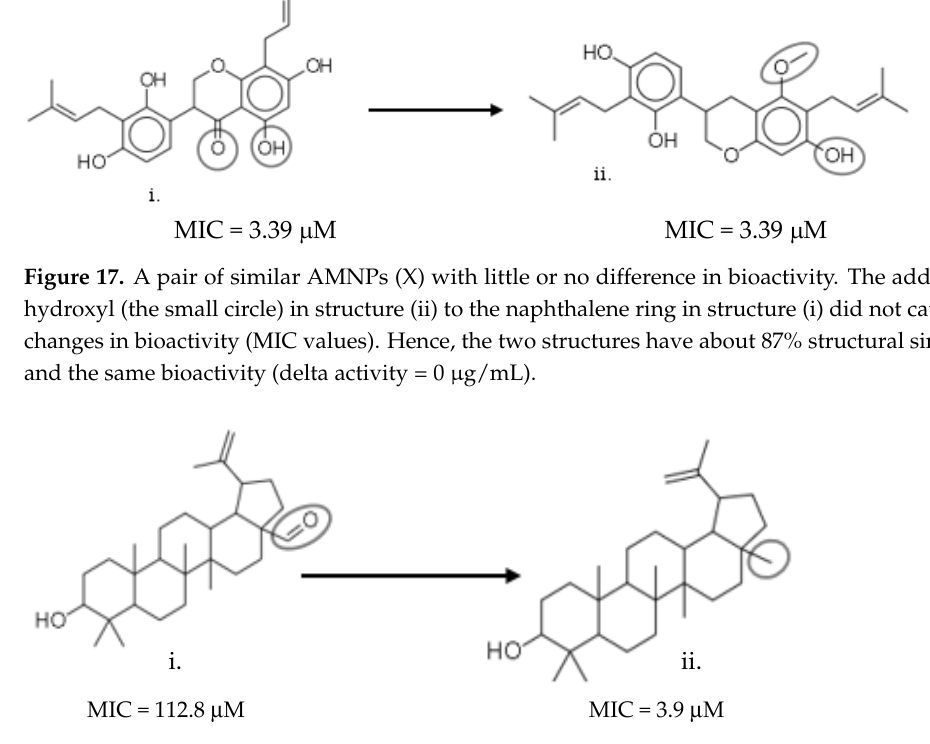
Figure 18. A pair of AMNPs (Y) showing an activity cliff. The two structures have about 94% similarity but are very widely different in bioactivity (delta activity = 256.1 µg/mL). An aldehyde group in structure (i) (the small circle) replaced by a methyl group in structure (ii) (the small circle) caused a significant difference in bioactivity.